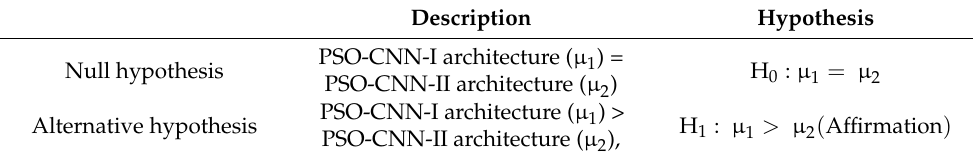
Table 16. General description of the Wilcoxon test.